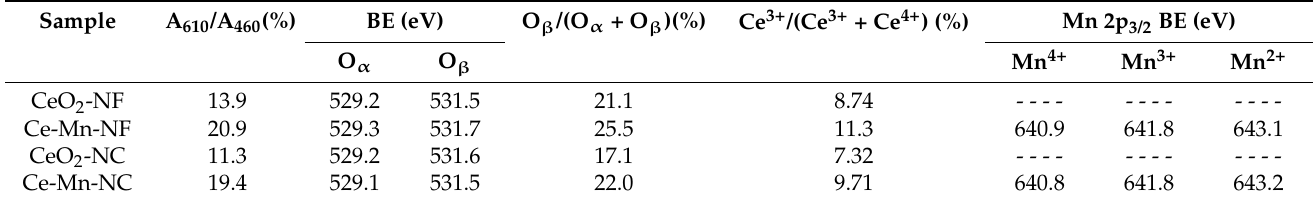
Table 2. Physical and chemical properties of all